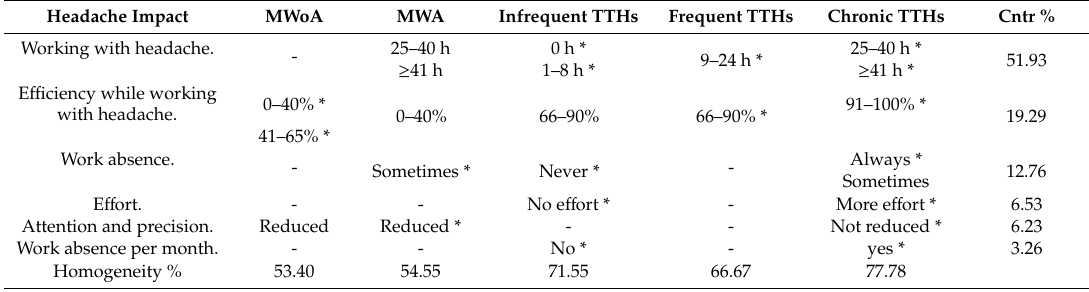
Table 5. Impact of headaches on work in relation to headache subtype. Cntr, contribution of item to characteristics; MWoA, migraine without aura; MWA, migraine with aura. Headache Impact MWoA MWA Infrequent TTHs Frequent TTHs Chronic TTHs Cntr % Working with headache. - 25–40 h 0 h * 25–40 h * 9–24 h * 51.93 ≥ 41 h 1–8 h * ≥ 41 h * E ffi ciency while working 0–40% * 91–100% * with headache. 0–40% 66–90% 66–90% * 19.29 41–65% * Work absence. - Always * Sometimes * Never * - 12.76 Sometimes - - No e ff ort * - More e ff ort * Reduced Reduced * - - Not reduced * 6.23 Work absence per month. - - No * - yes * 3.26 Homogeneity % 53.40 54.55 71.55 66.67